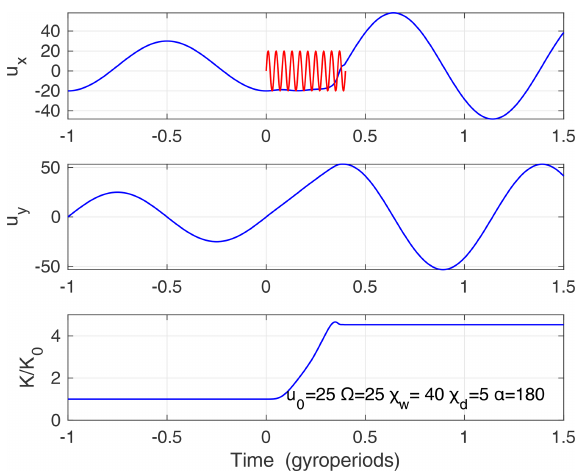
Figure 6. The same as in Fig. 5 but without the convection elec- tric field, i.e. χ d = 0. The waves are active a longer time during 0 . 75 f − 1 cp , and the propagation direction of waves is reversed, i.e. α = 0. Acceleration is the same but in the negative u y direction.